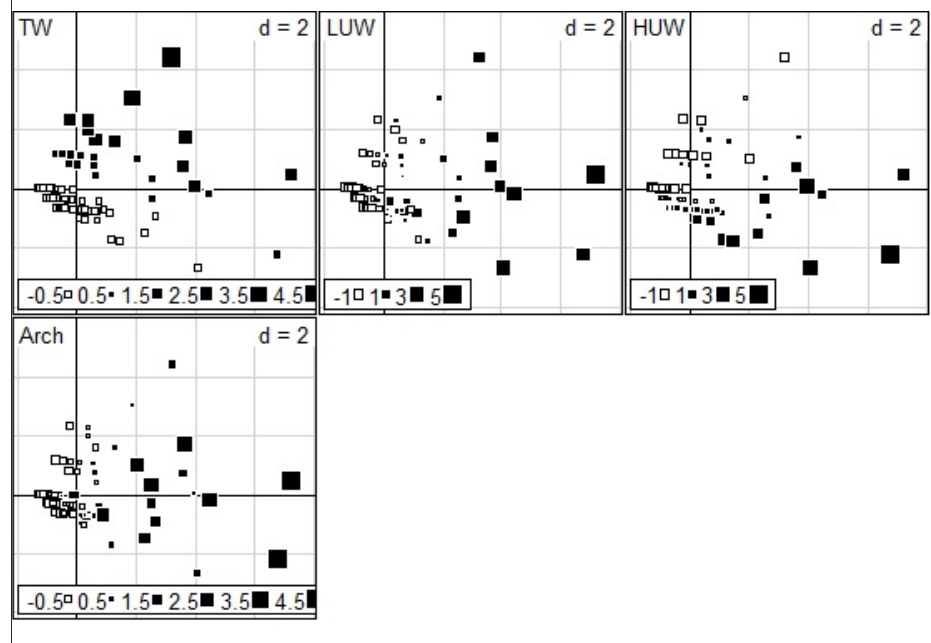
Figure 5: PCA-standardized matrix of functional wares in A205 (Isernia).